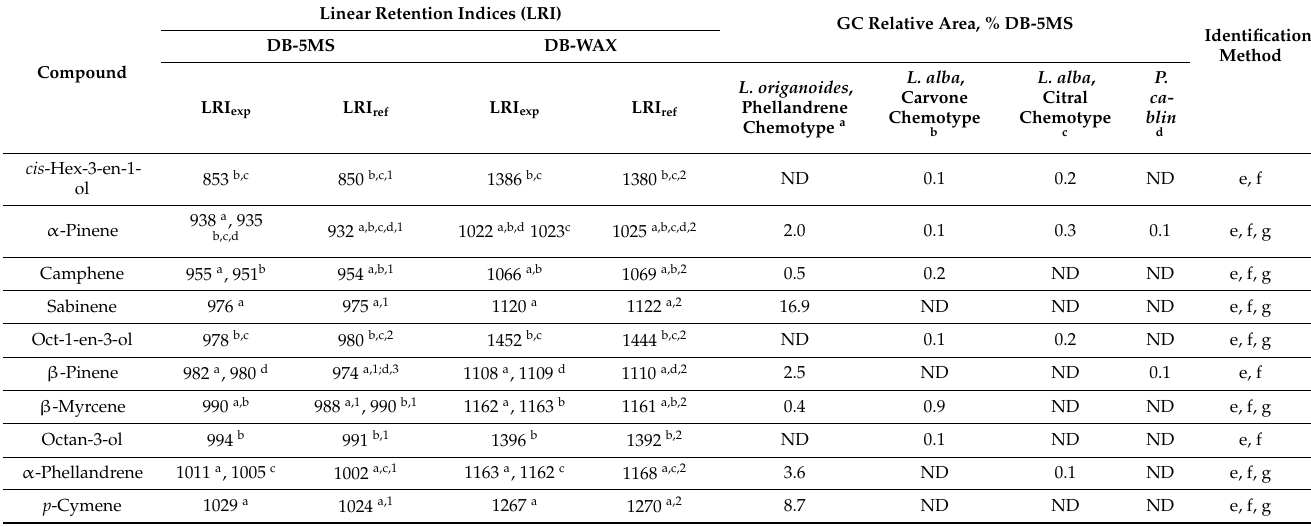
Table 1. Chemical composition of phellandrene-rich L. origanoides , carvone-rich L. alba , citral-rich L. alba , and P. cablin essential